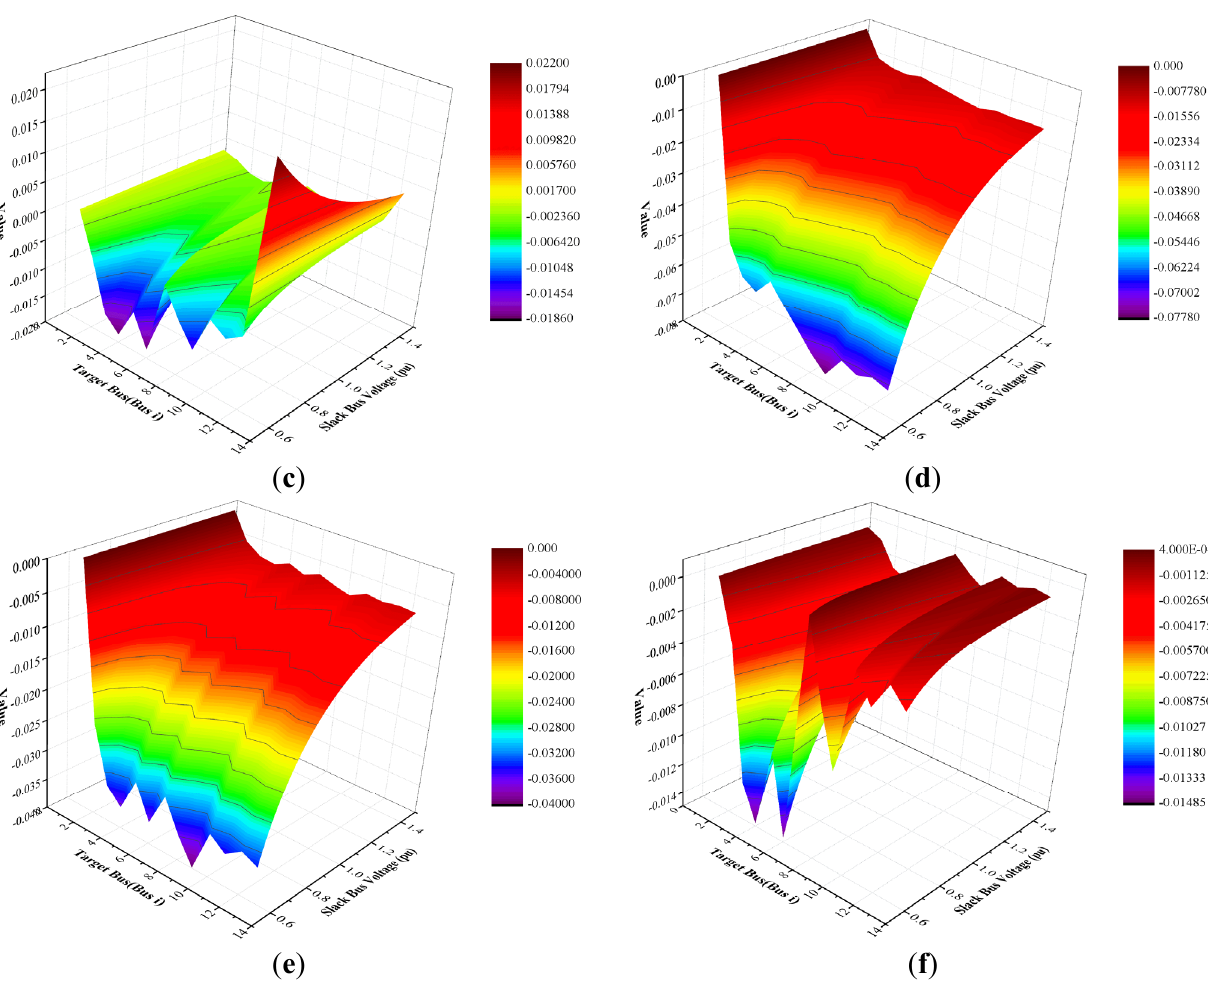
Figure 11. The results of Equation (42). ( a ) The injected power at bus 13 is − 1 MW; ( b ) The injected power at bus 13 is 0 MW; ( c ) The injected power at bus 13 is 1 MW; ( d ) The injected power at bus 7 is − 1 MW; ( e ) The injected power at bus 7 is 0 MW; ( f ) The injected power at bus 7 is 1 MW.